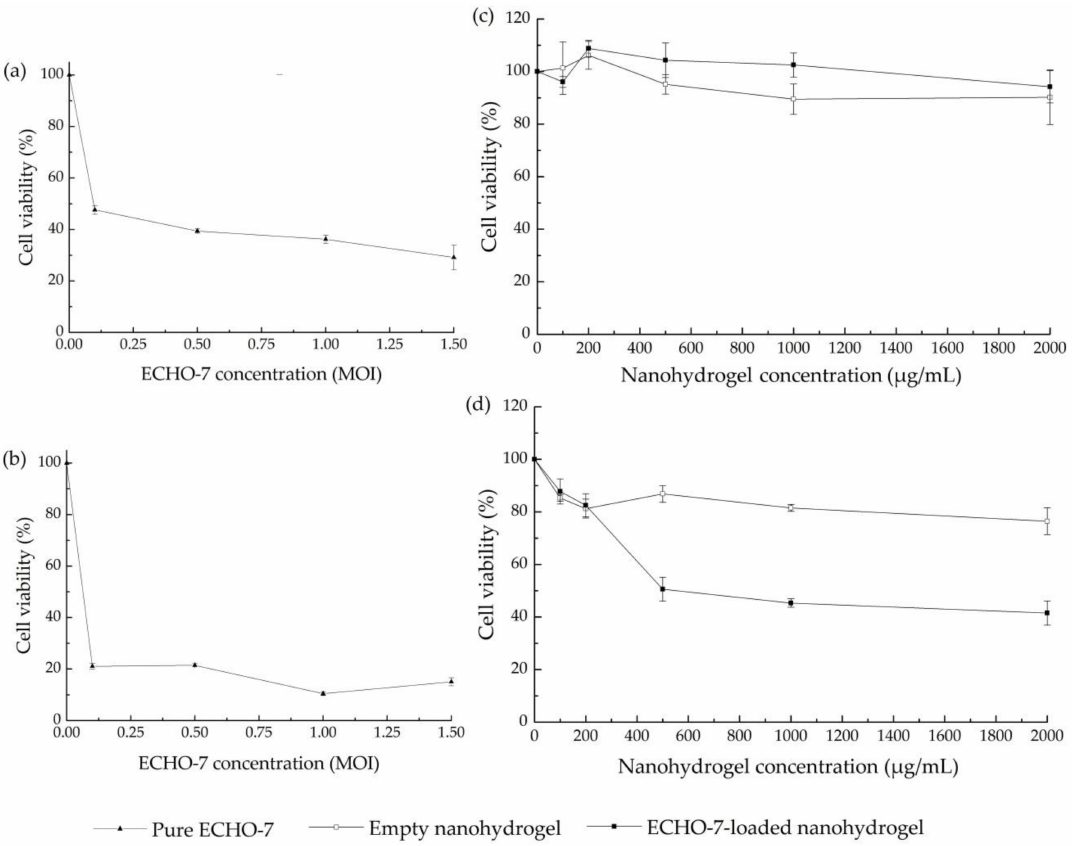
Figure 10. 3-(4,5-dimethylthiazol-2-yl)-5-(3-carboxymethoxyphenyl)-2-(4-sulfophenyl)-2 H -tetrazolium (MTS) cytotoxicity assays in HT29 colon cancer cell line of: ( a ) ECHO-7 after 5 days infection; ( b ). ECHO-7 after 7 days infection; ( c ) Empty nanohydrogel vs. ECHO-7-loaded nanohydrogel after 5 days infection; ( d ) Empty nanohydrogel vs. ECHO-7-loaded nanohydrogel after 7 days